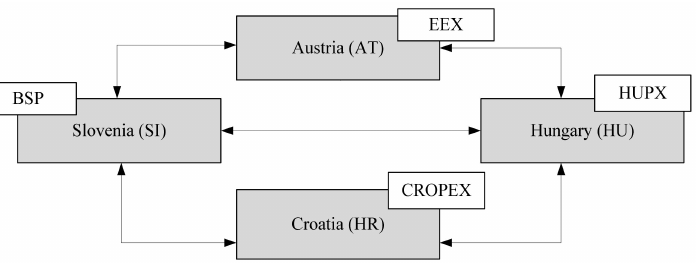
Figure 2. Depiction of the regional block consisting of Austria (AT), Slovenia (SI), Hungary (HU), and Croatia (HR) and possible power flows between